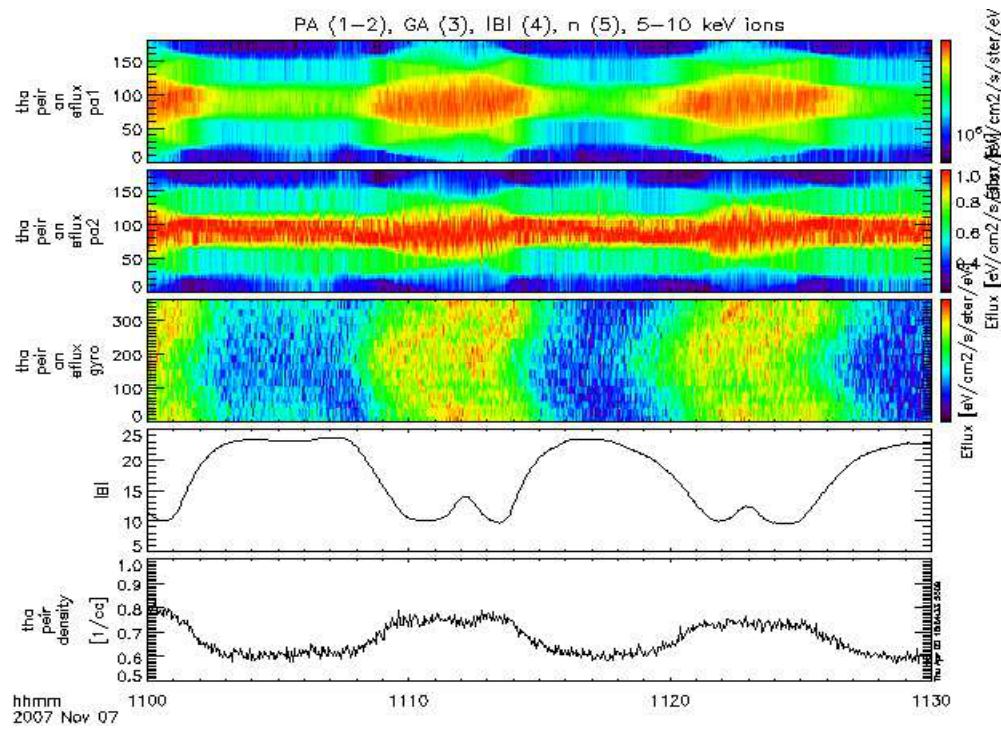
Fig. 7. Particle, magnetic and plasma data from 11:00UT to 12:24UT on 7 November 2007 observed by THEMIS-A. From top to bottom, the panels show the 5–10keV ion pitch angle distribution, the 5–10keV ion pitch angle distribution normalized to the peak flux during each spin, the 5–10keV ion gyrophase distribution integrated over pitch angles 45 ◦ –135 ◦ , the magnetic field magnitude, and the ion number density versus